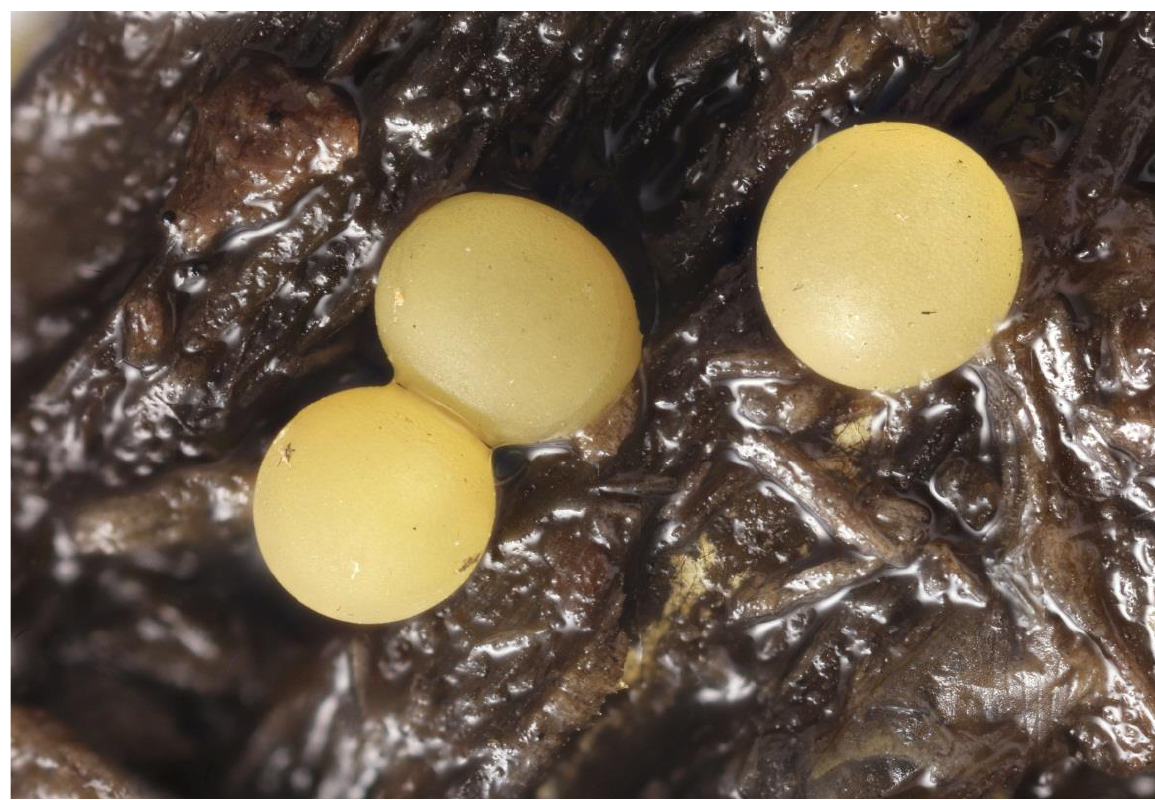
Figure 14. Platerodrilus svetae , eggs on substrate.